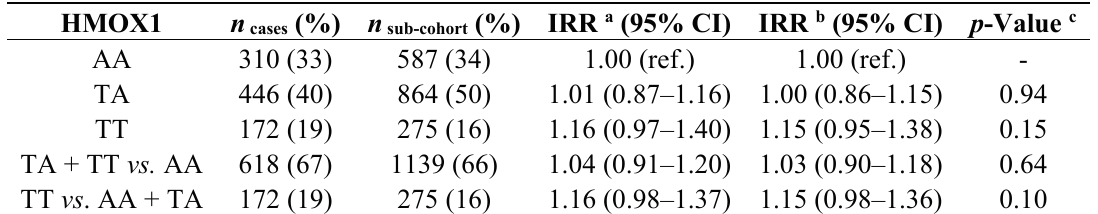
Table 2. Incidence rate ratios (IRR) for colorectal cancer in relation to HMOX1 A-413T